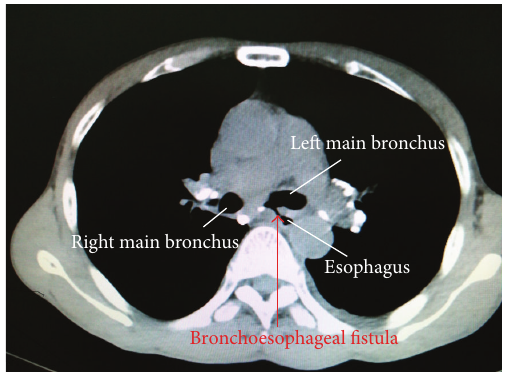
Figure 4: Correct position of the Y-shaped tracheobronchial stent, sealing the left bronchoesophageal